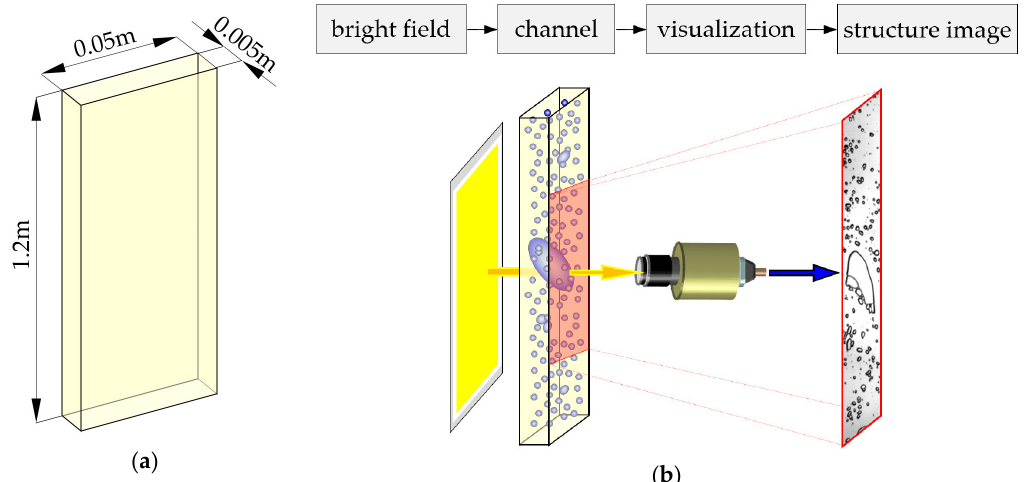
Figure 4. ( a ) Flow channel dimensions ( a ); bright field measurement technique diagram ( b ).